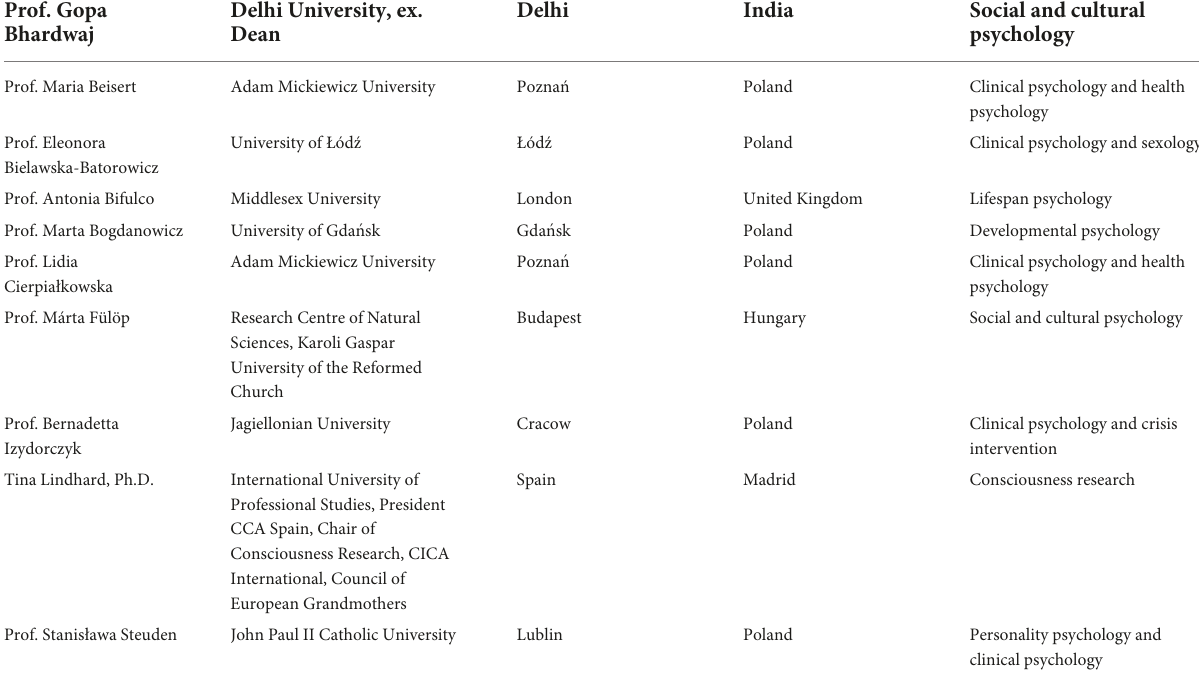
TABLE 1 The list of persons who participated in the study, including their affiliations, academic titles, country of origin and their expertise area of